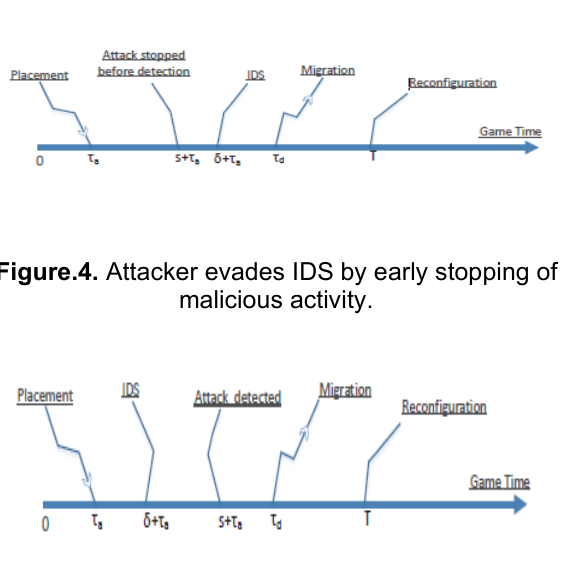
Figure.5. Attacker detected by Fuzzy based